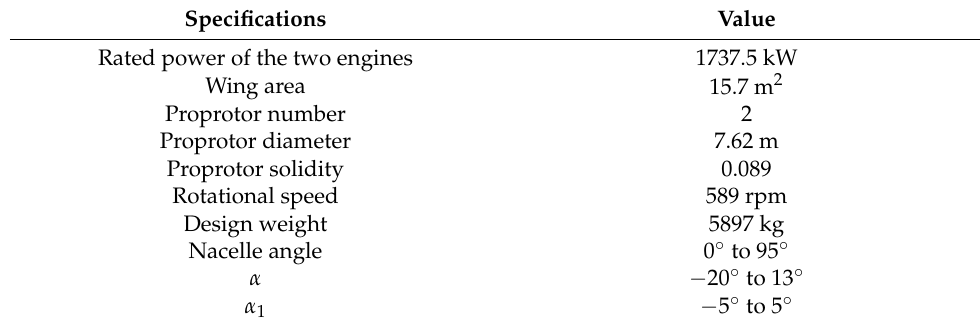
Table 3. XV-15 key specifications.